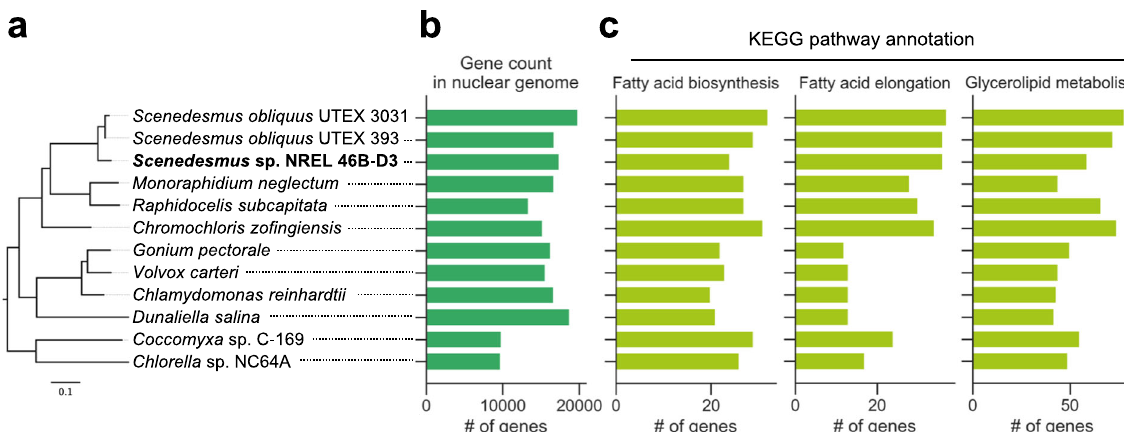
Fig. 3 Genome comparison of Scenedesmus sp. NREL 46B-D3 and related algae. a Maximum-likelihood phylogenetic tree of Scenedesmus sp. NREL 46B- D3 and related algae based on 606 single-copy orthologous genes. Bootstrap support values on all branches are 100%. Scale bar shows the mean number of nucleotide substitutions per site. b Number of predicted genes models in the nuclear genomes of related algae. c Number of genes assigned to lipid- related KEGG pathways: fatty acid biosynthesis, fatty acid elongation, and glycerolipid